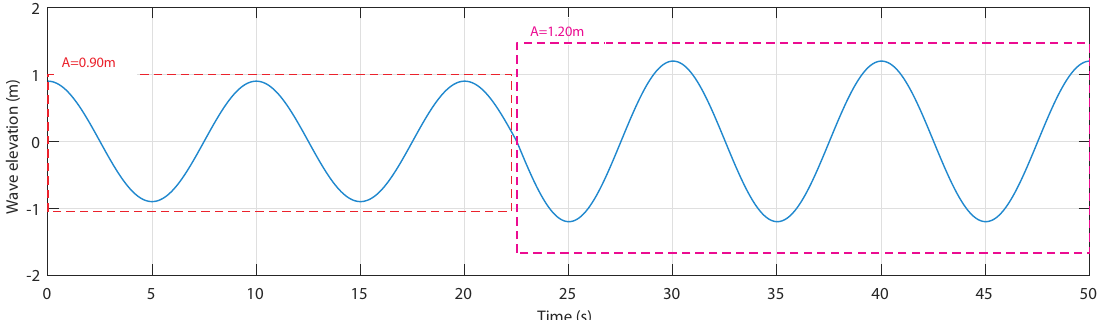
Figure 14. Considered wave input to the implemented OWC